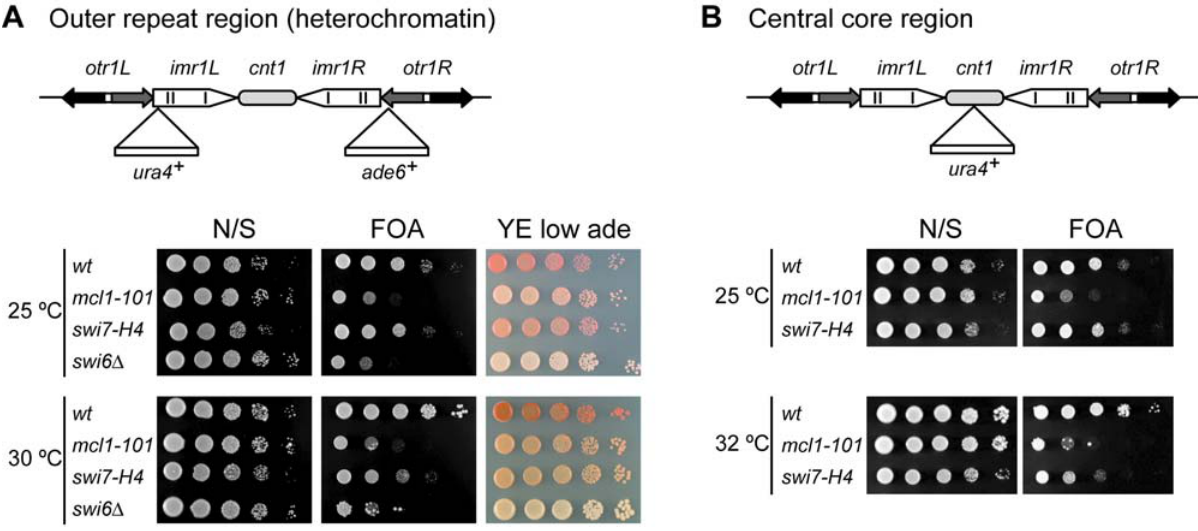
Figure 3. The mcl1-101 and swi7-H4 mutants display alleviation of transcriptional gene silencing at both central core and outer repeat regions. ( A ) (upper panel) The schematic diagram of ura4 + and ade6 + genes inserted into imr1L and otr1R , respectively. Note that the ura4 + gene is inserted into heterochromatic domain, which is defined as outside of tRNA genes (vertical lines) [23]. (lower panel) Tenfold serial dilutions were spotted. ( B ) (upper panel) The schematic diagram of the ura4 + gene inserted into cnt1 . (lower panel) Tenfold serial dilutions were spotted.